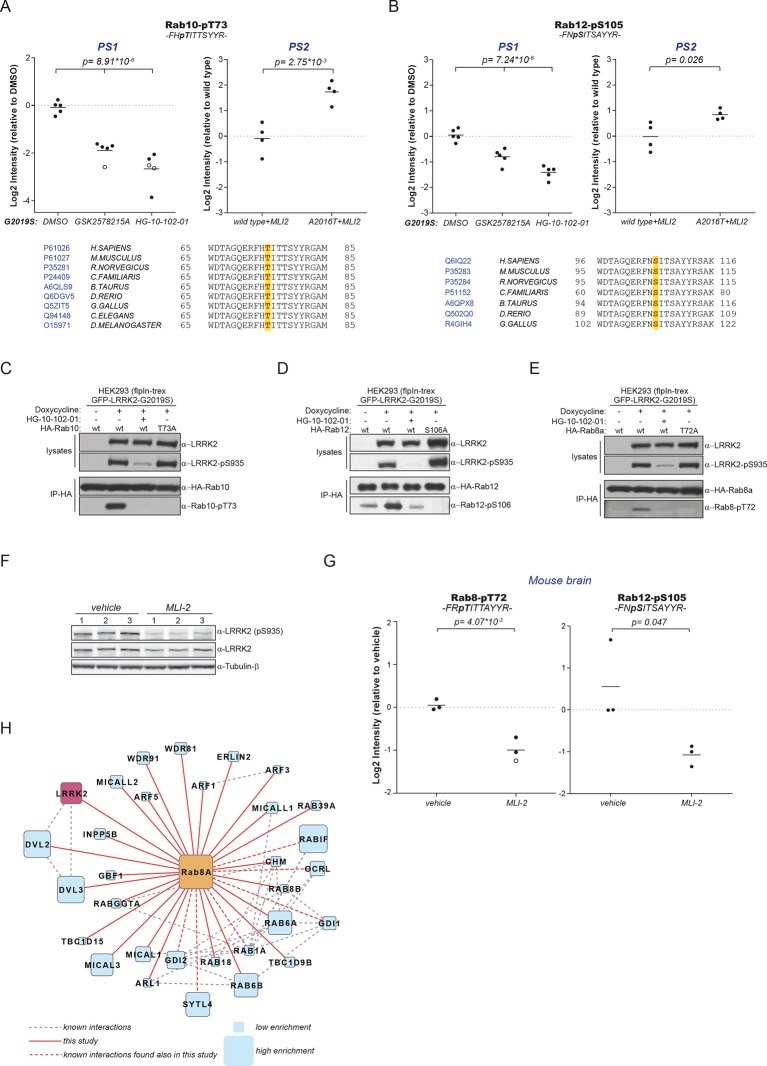
A number of Rab GTPases are physiological LRRK2 substrates.(A) MS-quantified pT73-Rab10 peptide intensities in PS1 and PS2. Sequence alignment of the T73-Rab10 region is shown below. (B) Same as (A) with pS106-Rab12. Western blots illustrating phosphorylation of T73-HA-Rab10 (C), S106-HA-Rab12 (D), and T72-Rab8 (E) after induction of LRRK2 expression by doxycycline (1 µg/ml). HG-10-102-01 (1 µM) was added prior to lysis. (F) Western blot of homogenized brain lysates from LRRK2-G2019SLilly mice injected with vehicle (40% HPβCD) or with 3 mg/kg MLI-2 (Biorep= biological replicate) and (G) MS-based quantification of pT72-Rab8 and pS105-Rab12 peptides. (H) Cytoscape network analysis of Rab8a interacting proteins determined by affinity-purification mass spectrometry (AP-MS). LRRK2 is in purple and dashed lines in grey show experimentally determined interactions from string database (http://string-db.org/).